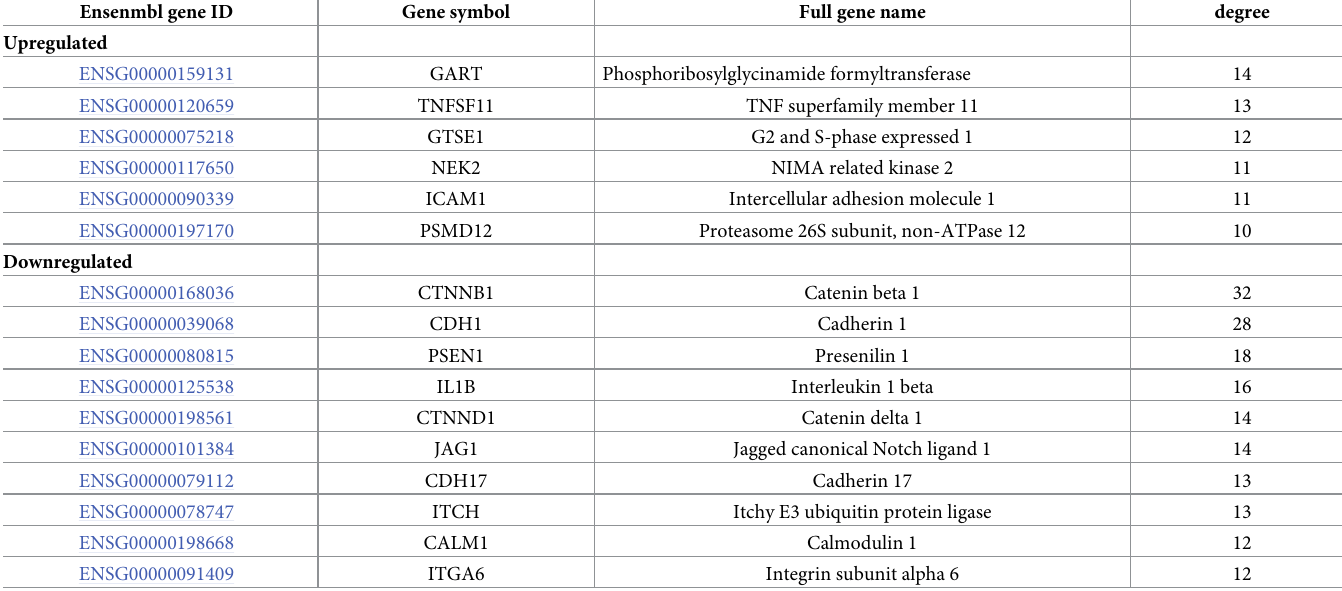
Table 3. Top 5% hub genes in the PPI networks.